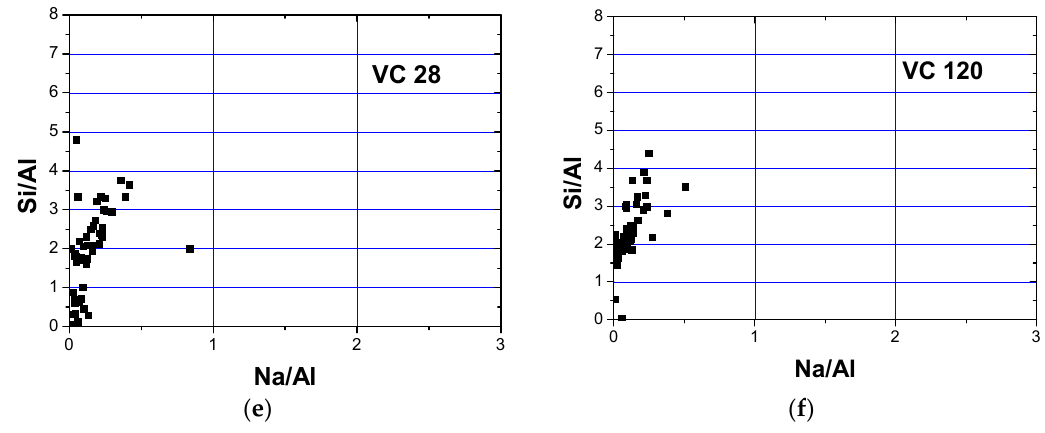
Figure 7. Atomic ratios Si/Al vs. Na/Al for ( a – c ) GP and ( d – f ) VC aggregates.